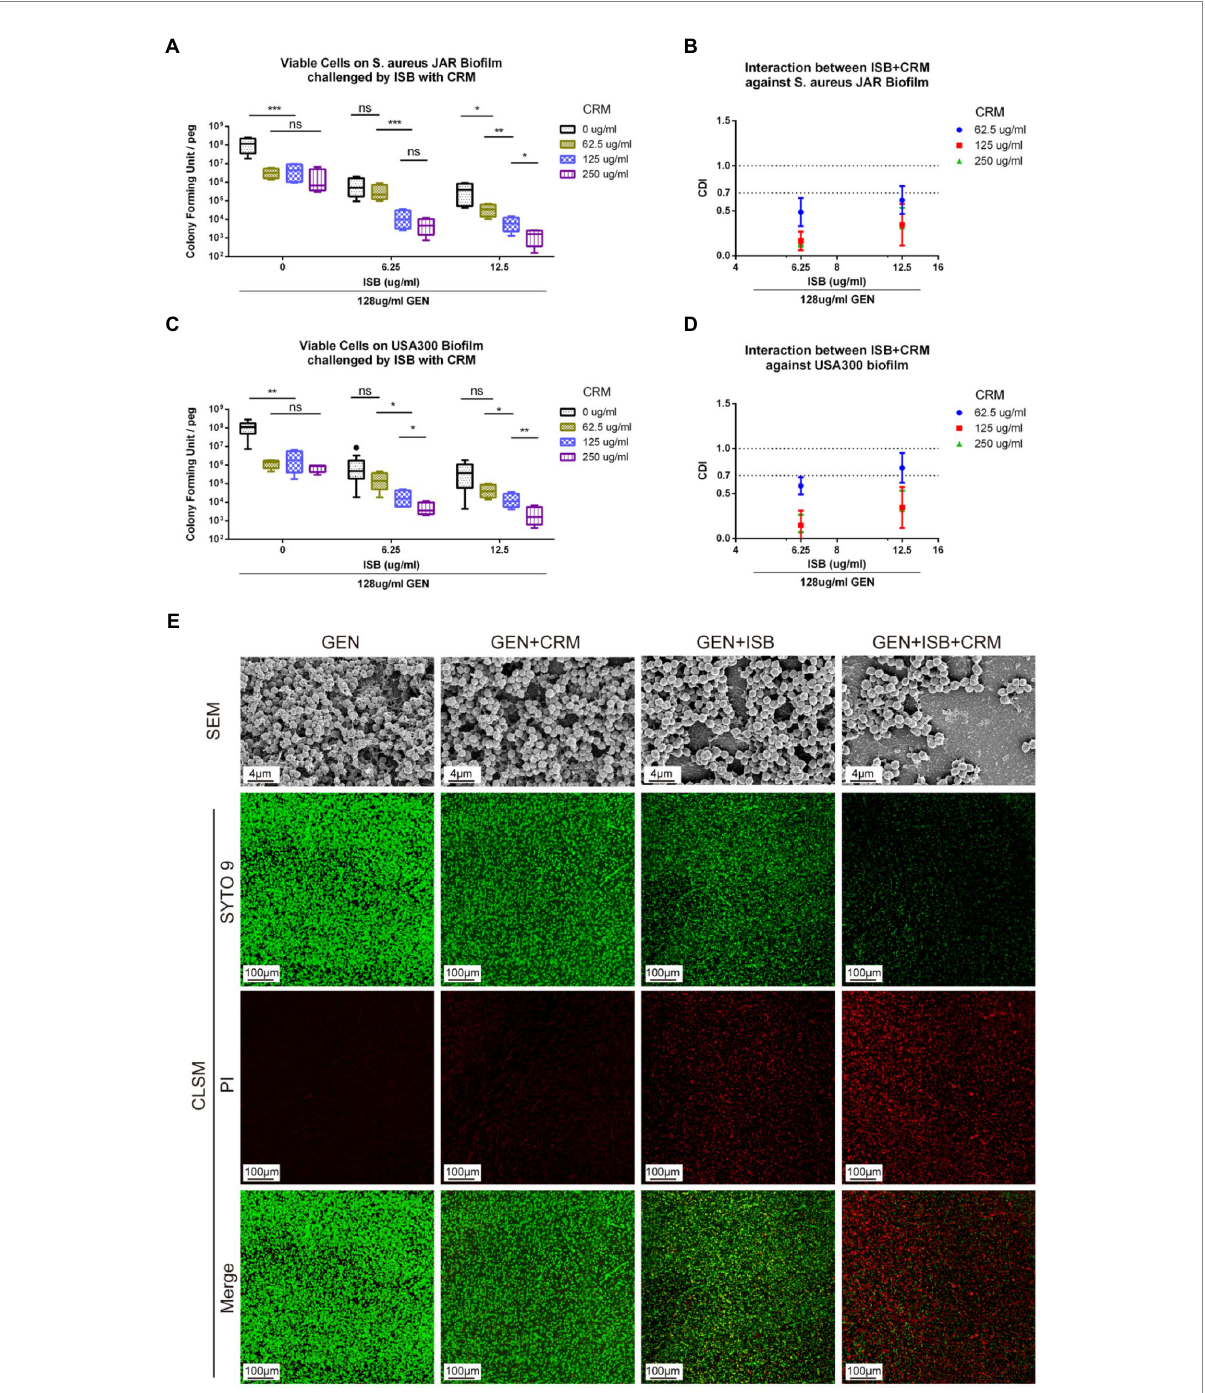
FIGURE 5 In vitro Eradication of Staphylococcus aureus biofilms by the GEN-ISB-CRM combination. (A,C) Quantification of residual viable cells on S. aureus JAR biofilm and USA300 biofilm, respectively. (B,D) Coefficient of Drug Interaction (CDI) shows synergy between Isobavachalcone and Curcumin with 128 μ g/ml Gentamycin against S. aureus JAR biofilm and USA300 biofilm, respectively. (E) Representative characteristics of MRSA USA300 biofilm after 24 h challenge. SEM: biofilms cultured at 37 ° C for 24 h were treated with 128 μ g/ml GEN (control), 128 μ g/ml GEN + 125 μ g/ml CRM, 128 μ g/ml GEN + 6.25 μ g/ml ISB, 128 μ g/ml GEN + 125 μ g/ml CRM + 6.25 μ g/ml ISB for 24 h, respectively. All SEM images were captured at EHT = 10 kV, Mag = 5KX. CLSM: representative confocal laser scanning microscopy (100× oil immersion) images of LIVE/DEAD ® BacLight staining showing the synergistic effect of different drug combinations on USA300 biofilm challenged for 24 h, green: live cells; red: dead cells. Data were presented as mean ± SD. * represents p < 0.05, ** represents p < 0.01, *** represents p < 0.01 when compared to 0 μ g/ml CRM with the same ISB concentration group, ns represents no significance. GEN, Gentamycin; ISB, Isobavachalcone; CRM, Curcumin; CDI, Coefficient of Drug Interaction; SEM, Scanning Electron Microscopy; CLSM, Confocal Laser Scanning